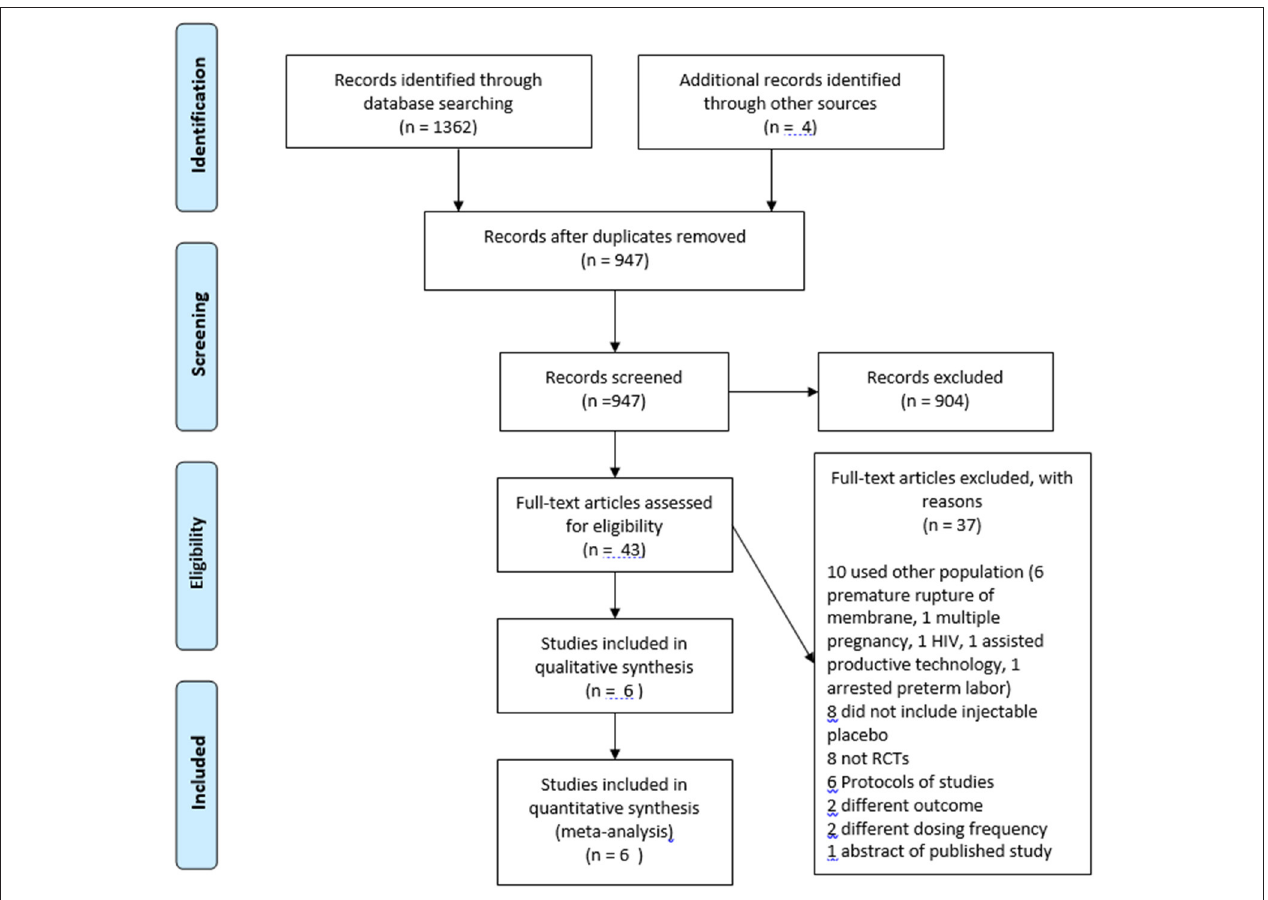
FIGURE 1 | Flowchart of included and excluded